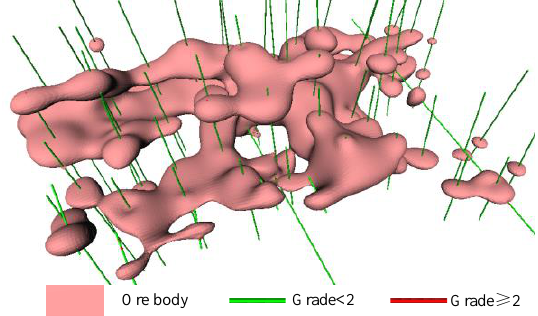
Figure 7. Ore body model constructed from drill-hole data